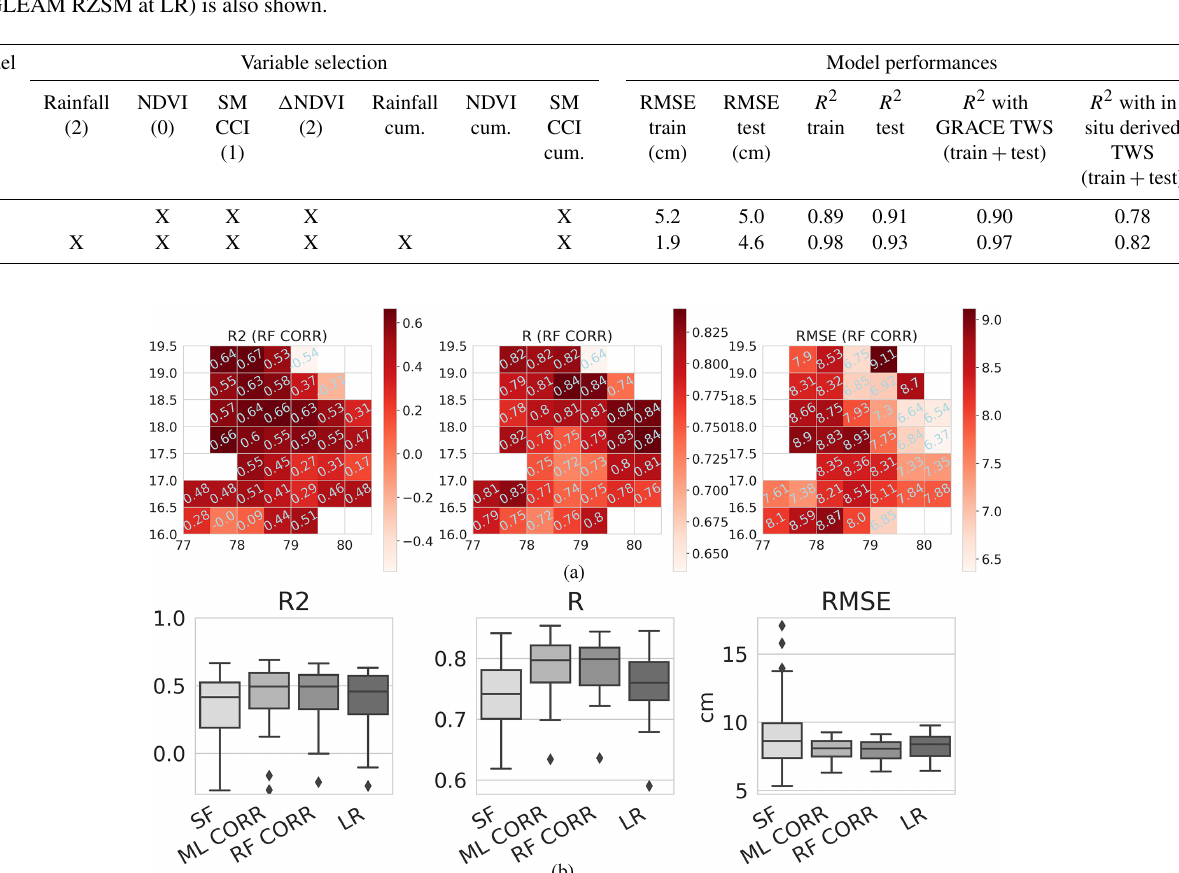
Table 4. Variable selection and model performance at LR. The number in parentheses is the number of lag months. Variables with the suf- fix “cum.” are cumulated over the last year. The underlined variables were eliminated with the VIF selection method. The model performance is evaluated against GRACE TWS with the R 2 and the RMSE on train and test sets. The R 2 with in situ derived TWS (sum of GWS-OW and GLEAM RZSM at LR) is also shown.